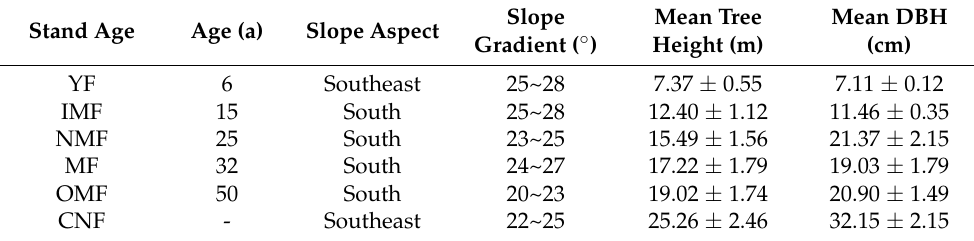
Table 1. Basic condition of plots of Chinese fir plantations at different ages: YF (young forest, six years old), IMF (immature forest, 15 years old), NMF (near-mature forest, 25 years old), MF (mature forest, 32 years old), OMF (over-mature forest, 50 years old), CNF (close-to-natural forest, average age was 50 years old); all forests were tended (weeding and fertilizer) in the first three years, all forests except for YF underwent intermediate cutting at eight years old, all forests beside YF and NMF underwent intermediate cutting at 18 years. CNF indicates an uneven-aged forest; the oldest Chinese fir was about 120 years old with a diameter of about 63.8 cm (24 October 2018). The mean and standard deviation were calculated from three stands with the same age; DBH is the diameter at breast